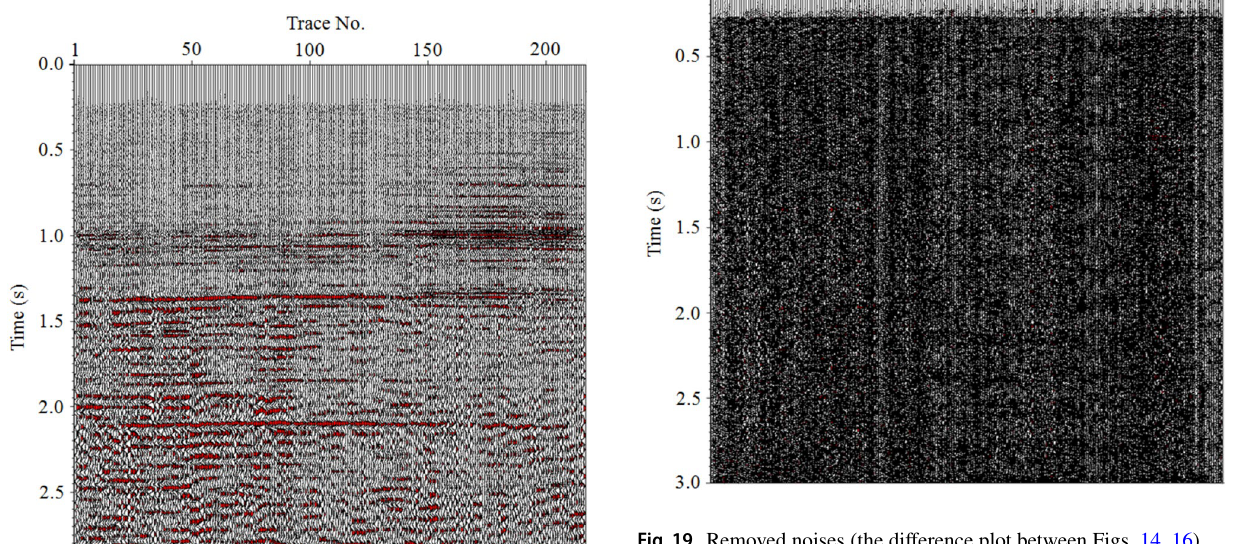
Fig. 19 Removed noises (the difference plot between Figs. 14,